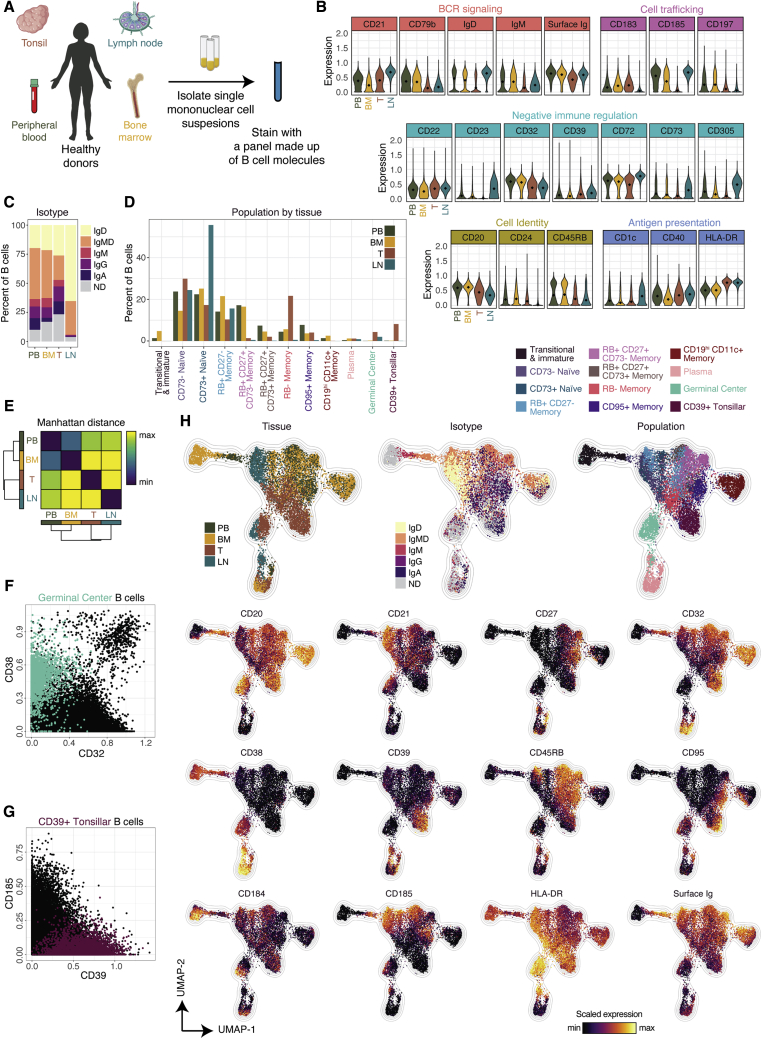
Characterization of lymphoid tissue-specific B cell populations(A) Experimental workflow (n = 11 donors).(B) Violin plots of molecules significantly differentially expressed by at least two tissues (p < 0.005).(C) IgH isotype usage by tissue. ND denotes “not determined”; IgMD denotes co-expression of IgM and IgD.(D) Subset composition by tissue.(E) Manhattan distance between each tissue based on subset composition.(F) Biaxial of B cells colored as GC or other.(G) Biaxial of B cells colored as CD39+ tonsillar or other.(H) UMAP plot generated from an equal subsampling by tissue, then an equal subsampling by subset.